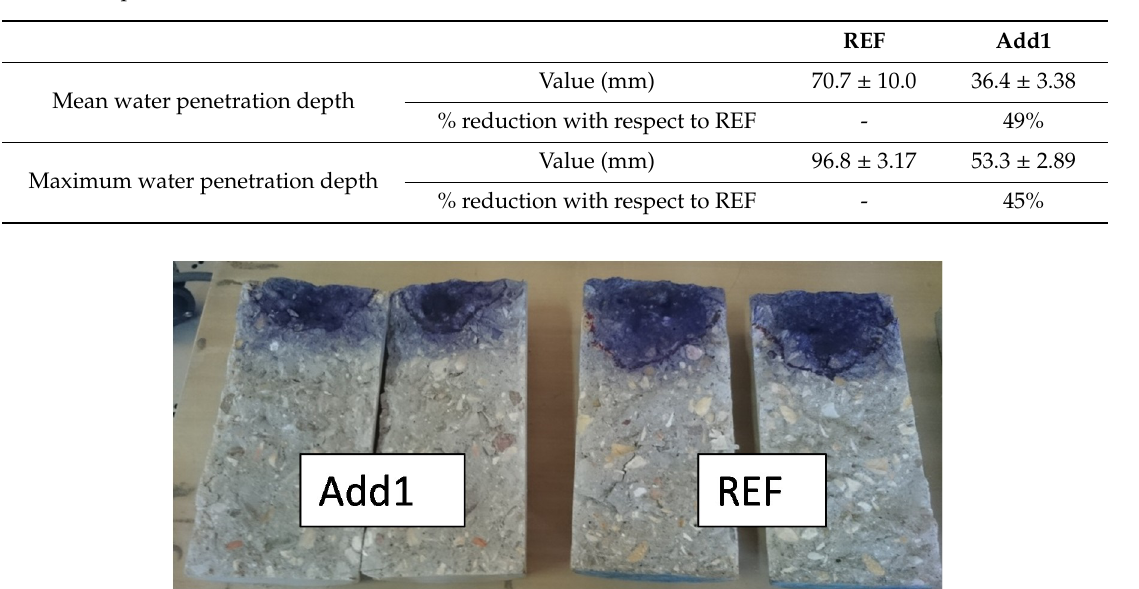
Table 4. Mean and maximum water penetration depths (mm) recorded after the penetration of water under pressure test.